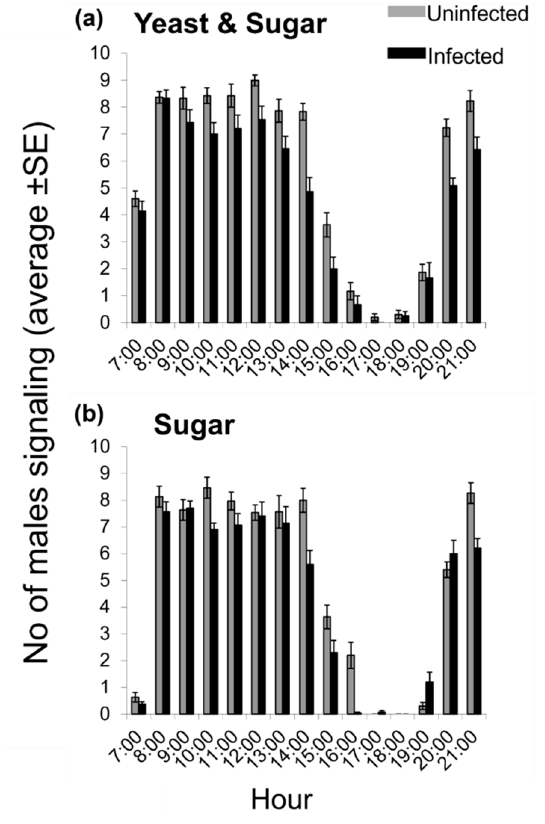
Figure 2. Daily rhythm of sexual signaling on adult day 5 of Ceratitis capitata males uninfected and infected with Wolbachia fed on a ( a ) yeast plus sugar (YS) and ( b ) sugar only (S) diet. The values on the y -axis are mean numbers (±SE) of males signaling per cage per hour observation. The grey and black bars represent the uninfected and infected line, respectively. Table 2. Repeated measures analysis of variance on the effect of infection (first factor), food (second factor), and hour of the day (repeated factor) on Ceratitis capitata male sexual signaling. Times of day from 7:00 to 15:00 (the most sexually active period of the day) of adult day 5 were considered in the analysis.